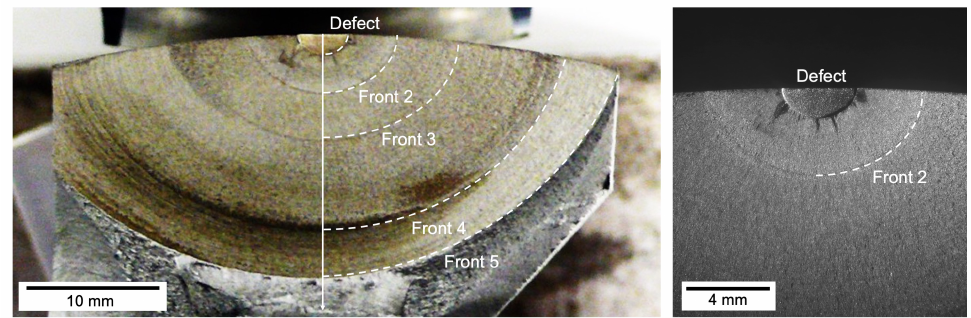
Figure 4. Final fracture surface of Axle S064 and reconstruction of crack shape evolution by fitting ellipses.